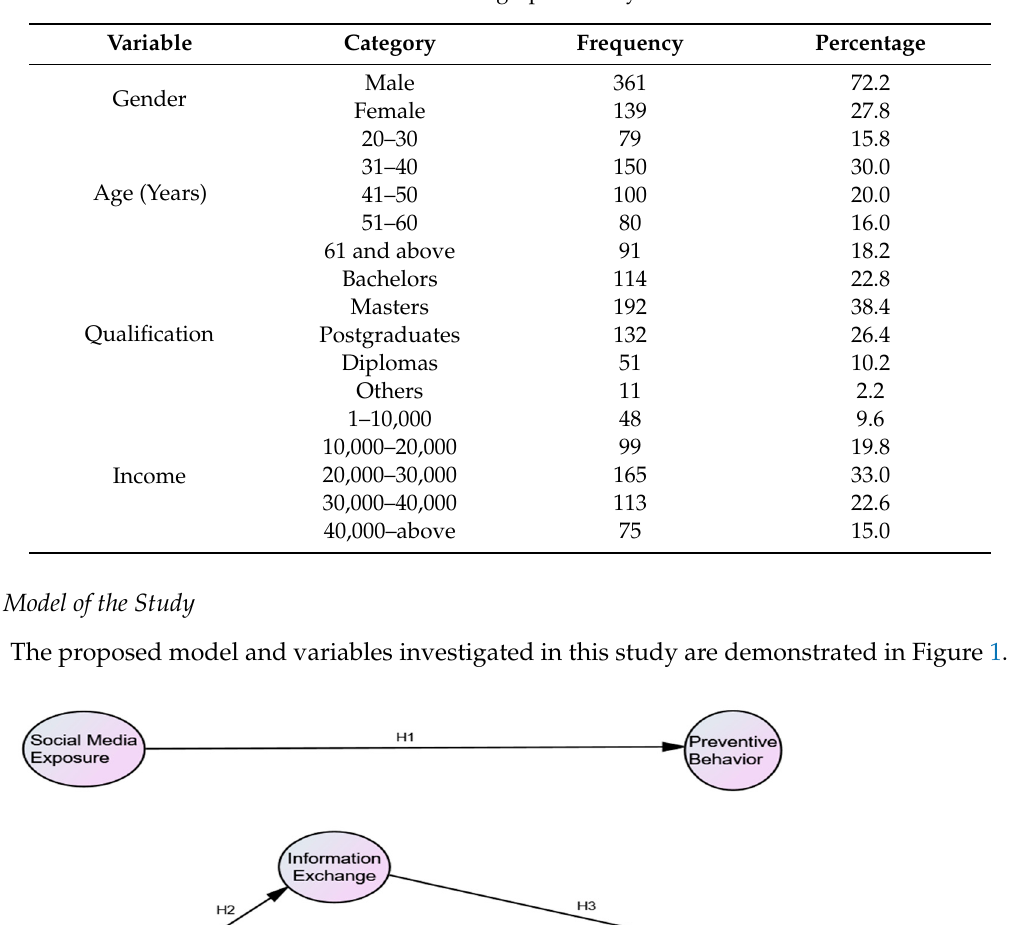
Table 1. Demographic Analysis.